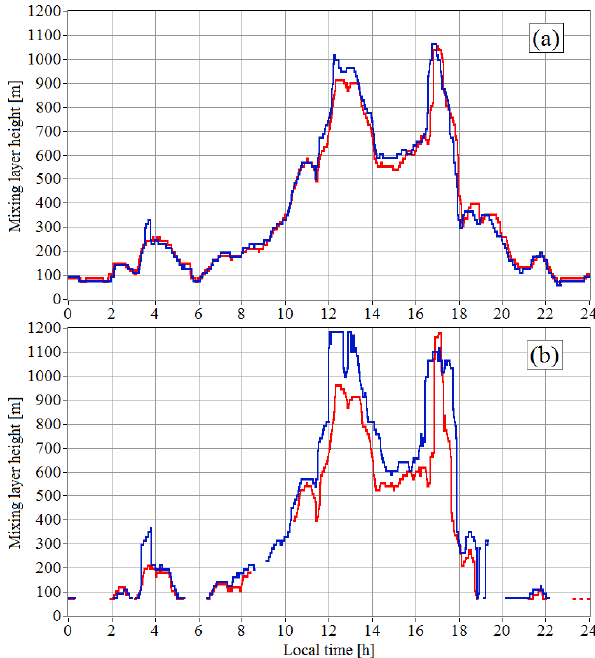
Figure 4. Temporal series of the turbulent mixing layer height (thickness) obtained from spatiotemporal distributions of the tur- bulence energy dissipation rate (a) and the variance of radial veloc- ity (b) . Scanning at elevation angles of 60 ◦ (red curves) and 35.3 ◦ (blue curves). Measurements were taken on 21 July 2019. The data of Figs. 2 and 3 are